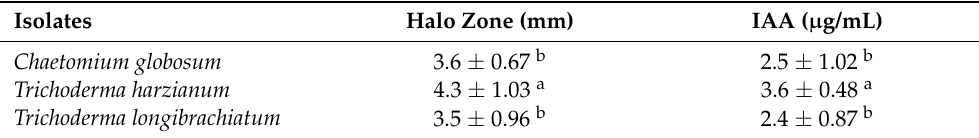
Table 1. Production of siderophore and indole-3-acetic acid (IAA) by selected endophytic fungal bioagents.